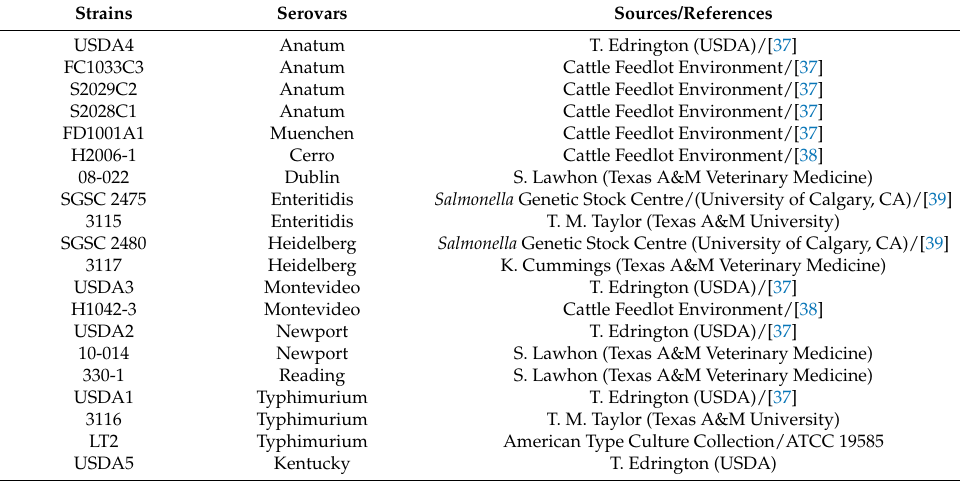
Table 1. Bacterial strains used in this study and their